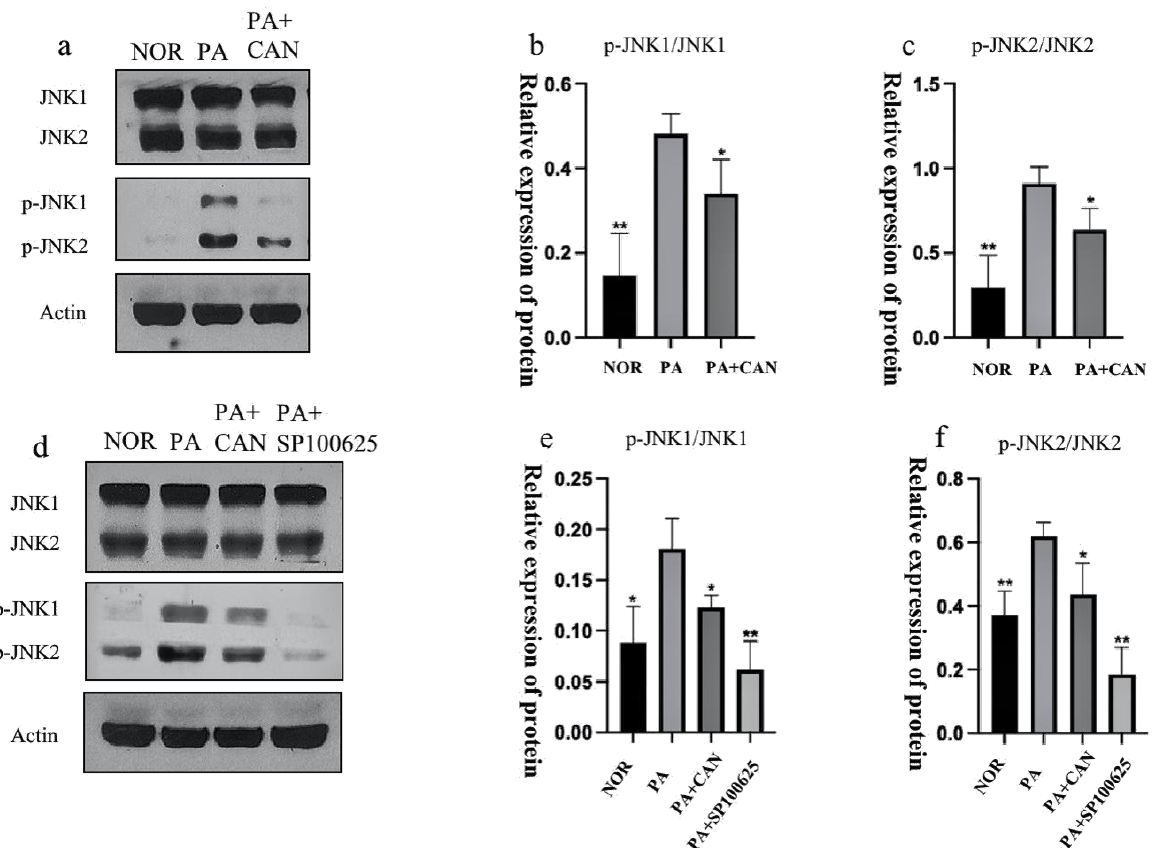
Figure 8. CAN inhibited JNK protein activation. ( a – c ) CAN (5 µg/mL) reduced the phosphorylation levels of JNK1 and JNK2 proteins. ( d – f ) Effects of JNK inhibitor SP100625 (10 µM) on JNK and JNK2. Data are expressed as the means ± SD ( n = 3); * p < 0.05, ** p < 0.01 vs. PA.